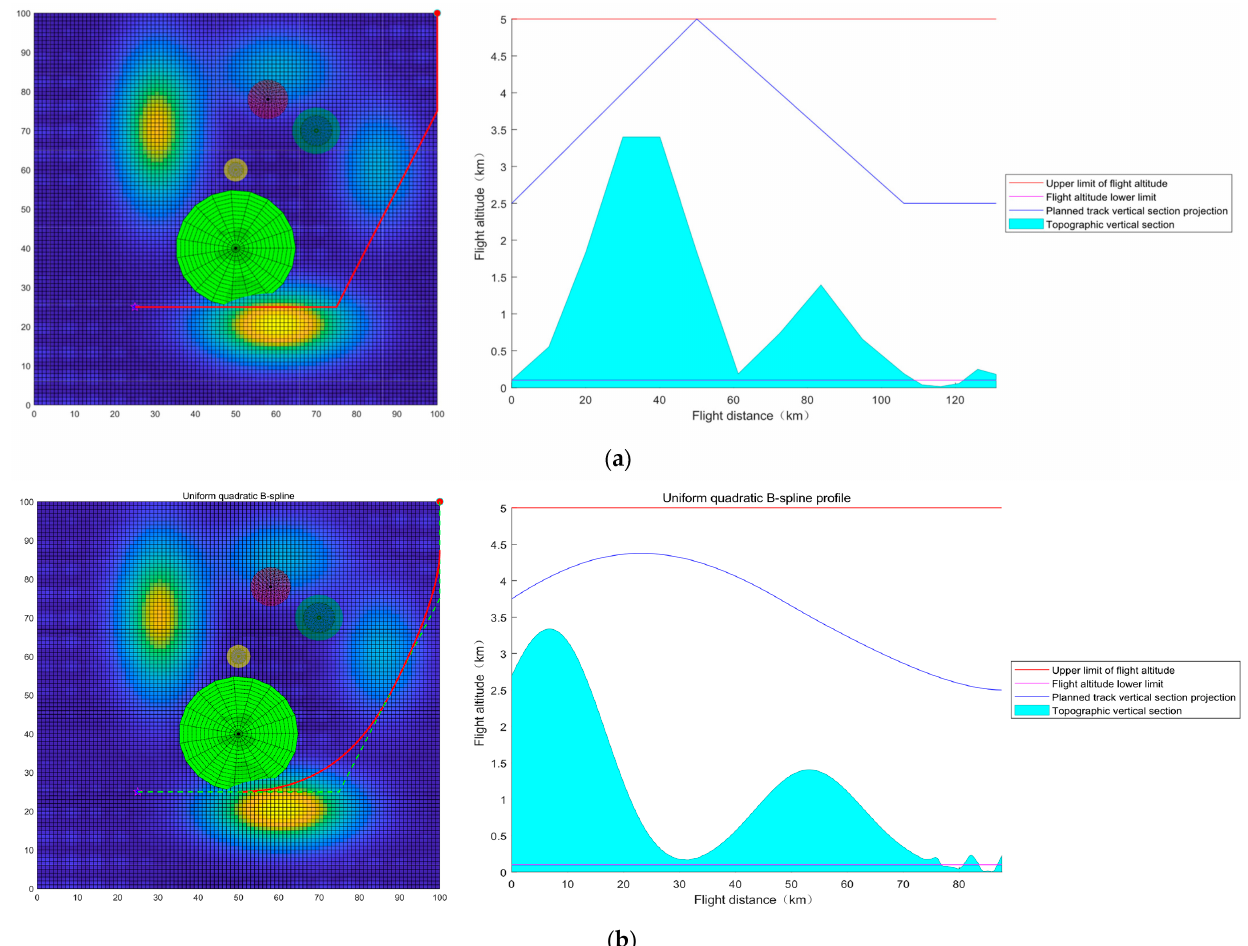
Figure A6 supplements the route smoothing simulation, including the smoothing results of the quadratic uniform B-spline and cubic uniform B-spline.